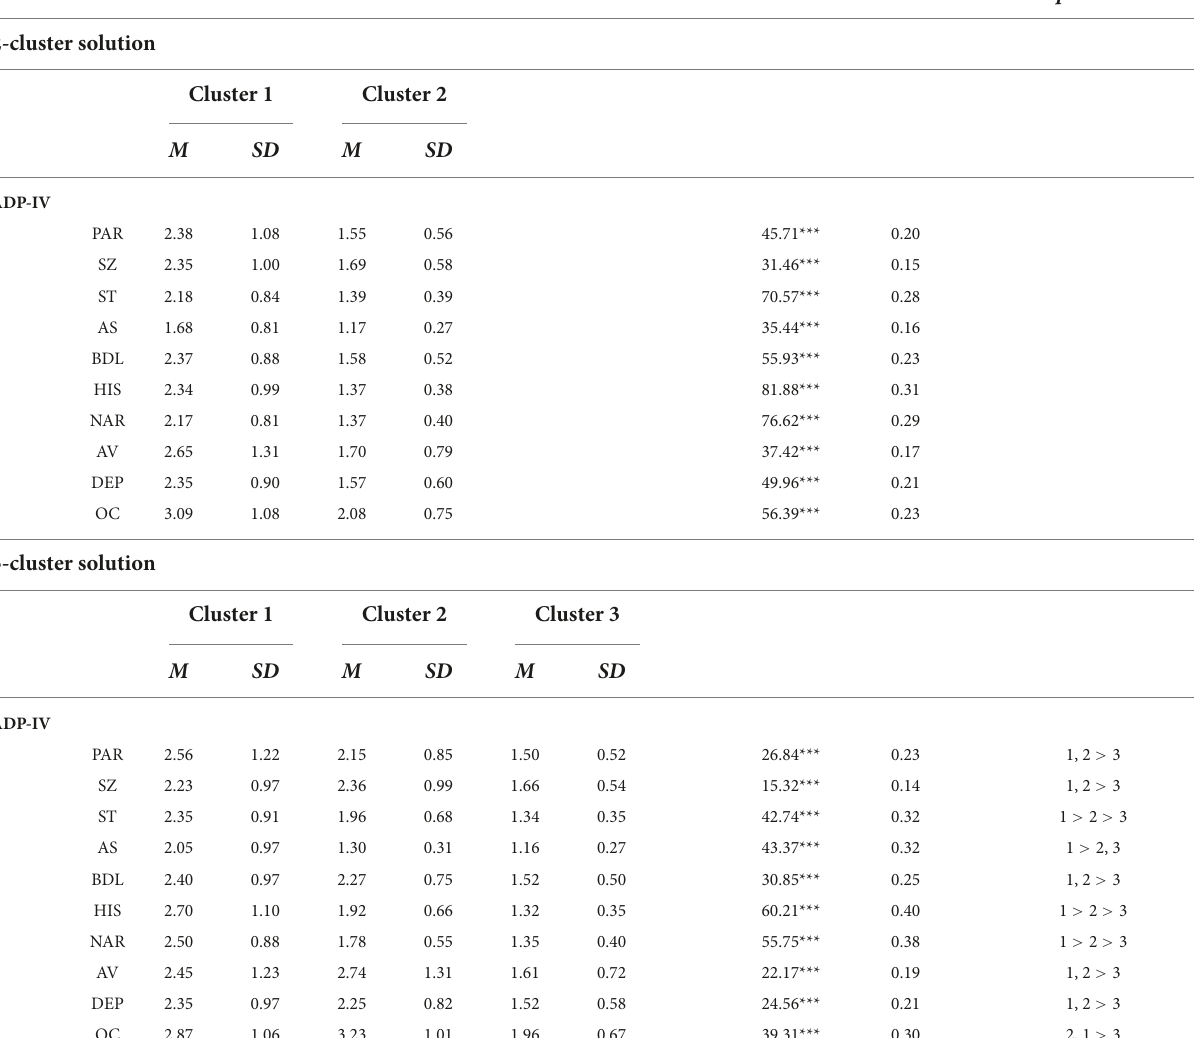
TABLE A1 Means and standard deviations of individual ADP-IV personality disorder scores for each PID5BF + M cluster solution.